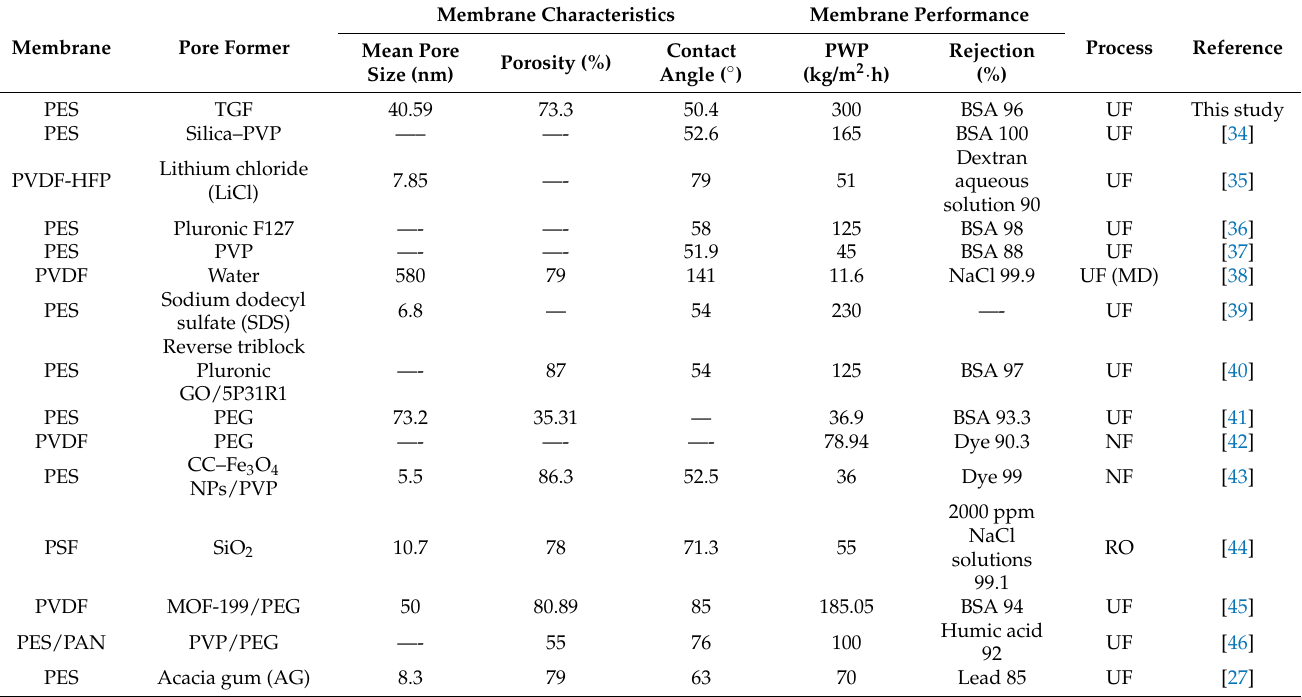
Table 2. Comparison of the membrane performance in this study with that of diverse membranes prepared in the literatures, regarding the pure water flux, retention percentage, and membrane